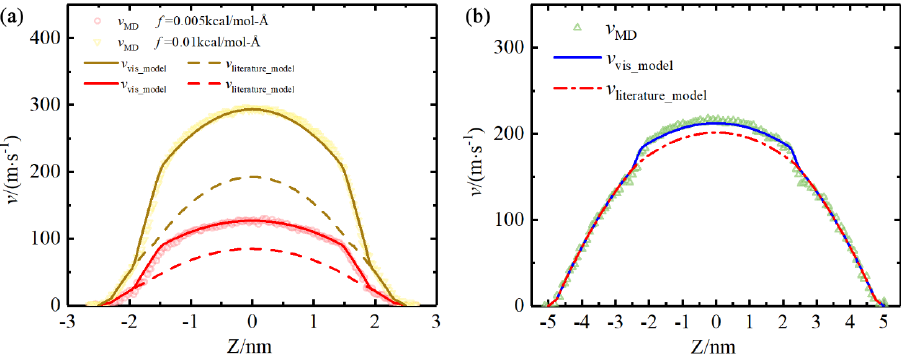
Figure 12. The comparison of velocity profiles calculated by various mathematical models and molecular simulation data: ( a ) 5 nm quartz pore; ( b ) 10 nm quartz pore.